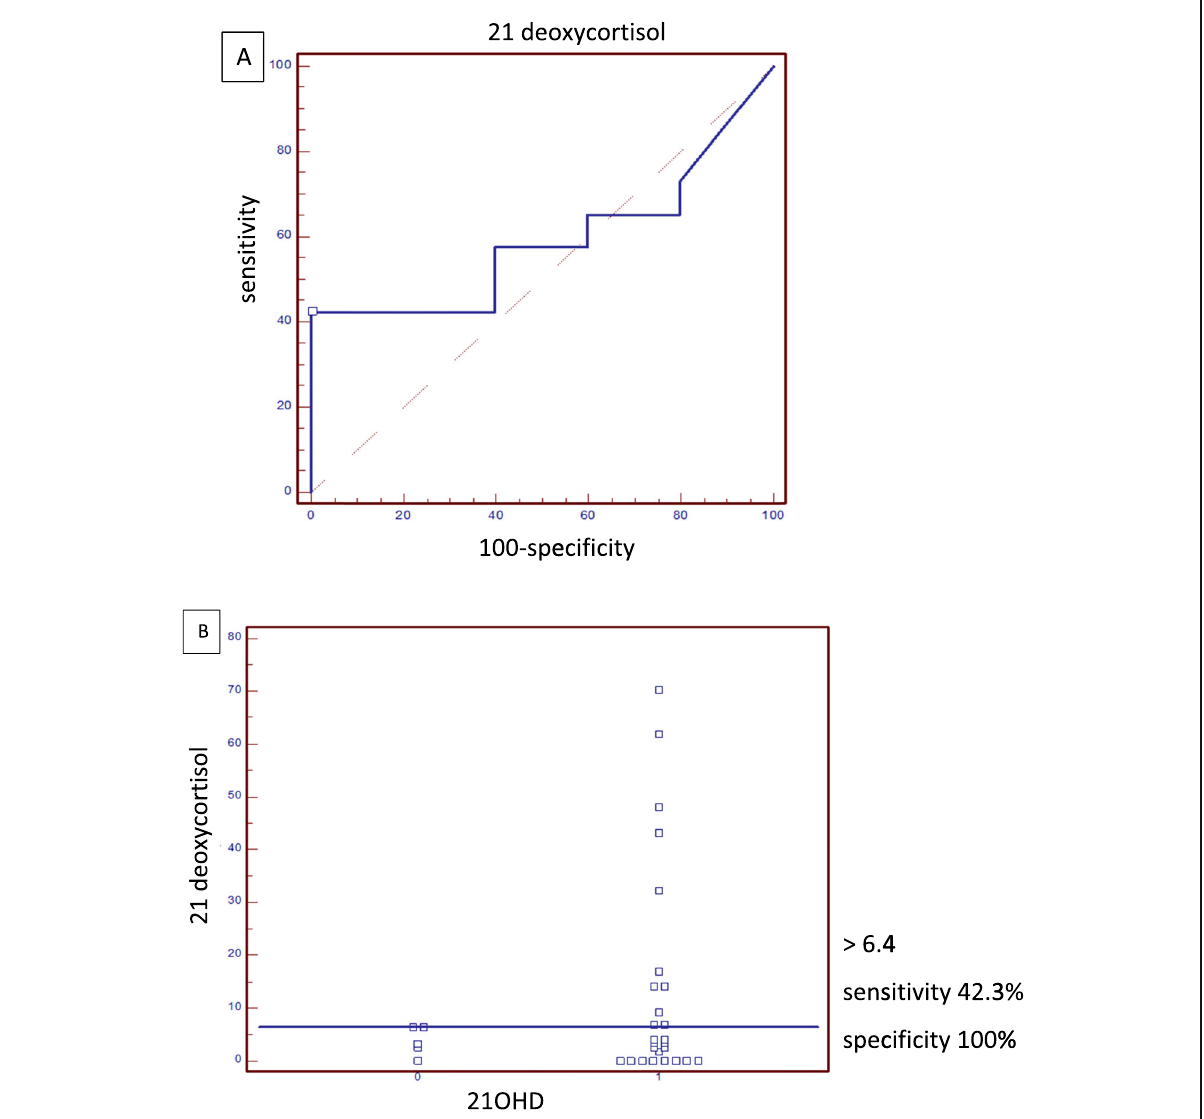
Fig. 3 a ROC curve of 21 deoxycortisol measured by LC MS/MS in diagnosis of 21OHD-CAH. b A dot plot chart for 21 deoxycortisol measured by LC-MS/MS in diagnosis of 21OHD-CAH shows that at a cutoff ≥ 6.4, specificity was 100% but sensitivity was